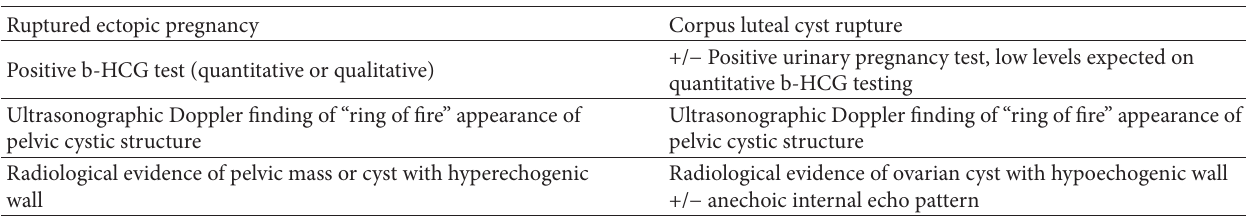
Table 2: Comparison of diagnostic criteria for ectopic versus corpus luteal cyst rupture.